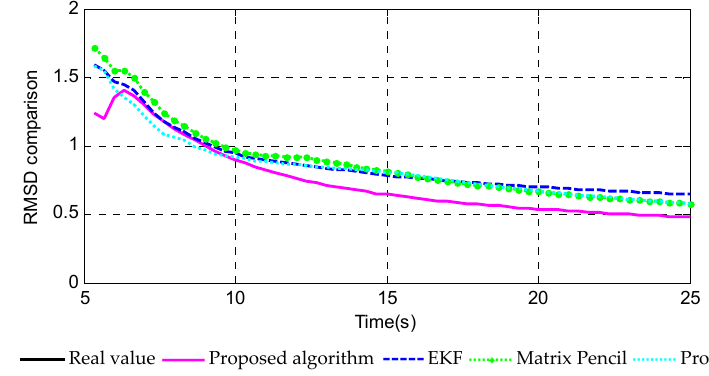
Figure 9. Estimation of